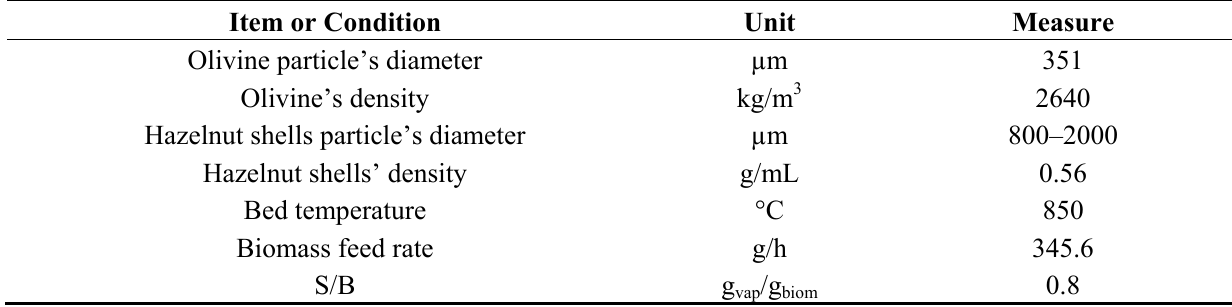
Table 4. Gasifier operating